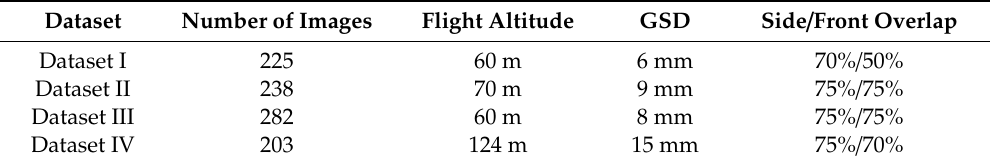
Table 4. Basic parameters of UAV